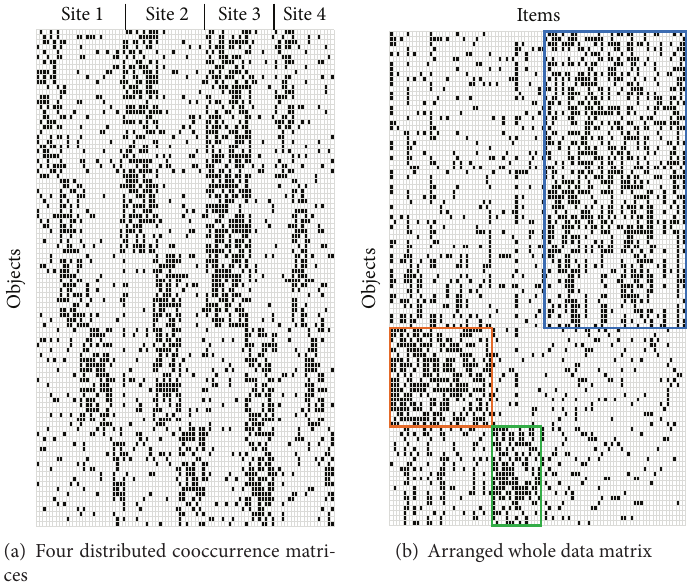
Figure 5: Artificially generated data with heterogeneous cluster partition.